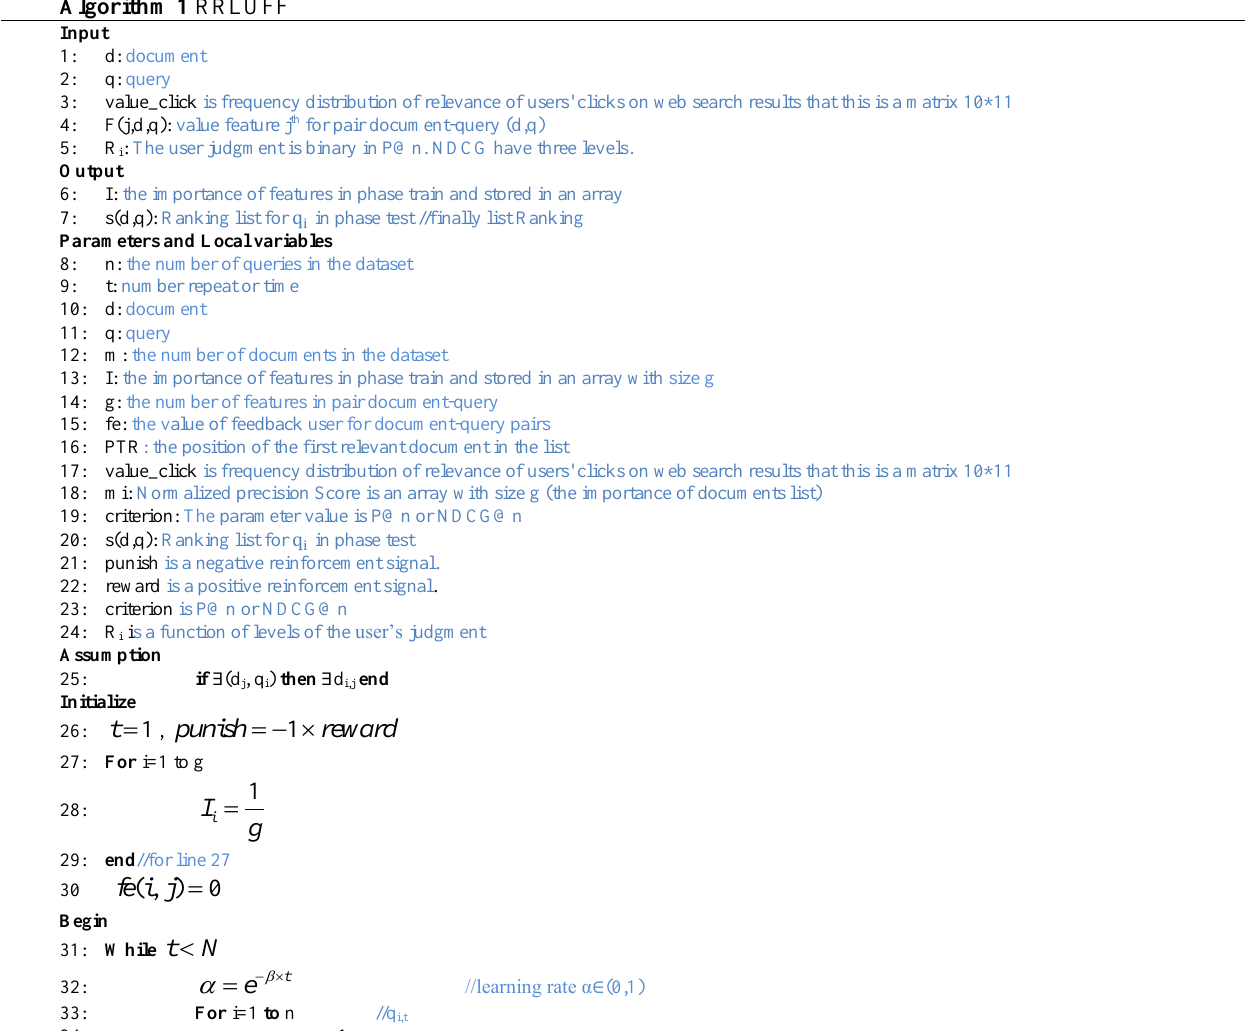
The pseudo-code and flowchart of the RRLUFF algorithm are shown in Algorithm 1 and figure 3, respectively.